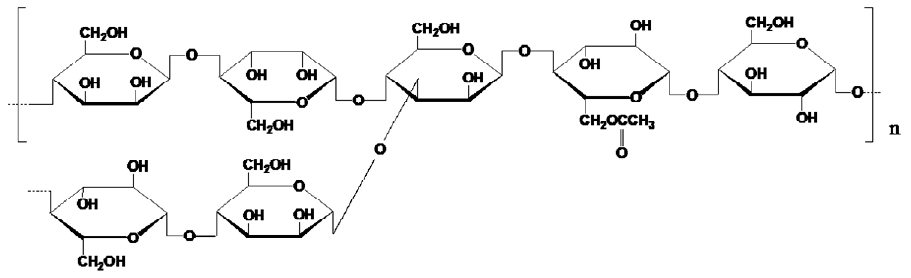
Figure 1. The chemical structure of konjac glucomannan.